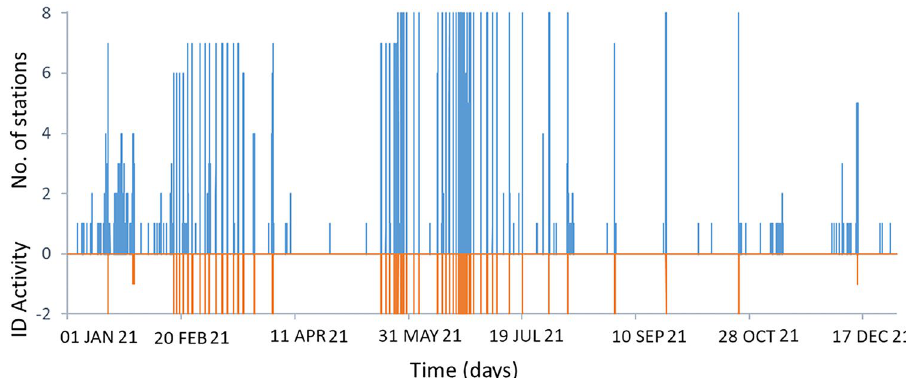
Figure 6. Number of stations reaching the threshold R = 0.58 (blue line, positive values) and volcanic activity (orange line) in 2021. The negative values in the y-axis are associated with the presence of strong effusive activity with ash emission (“− 1”) and lava fountains (“− 2”), respectively.